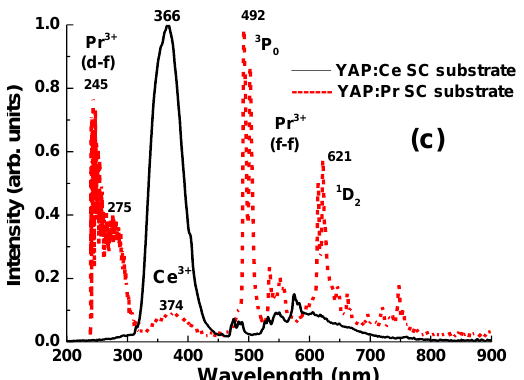
Figure 4. CL spectra of GdAP:Ce SCF/YAP:Ce SC ( a ) and YAP:Mn SCF/YAP:Ce SC ( b ) samples with different SCF thicknesses; ( c ) CL spectra of YAP:Ce SC (1) and YAP,Pr,Ce SC (2) substrates.